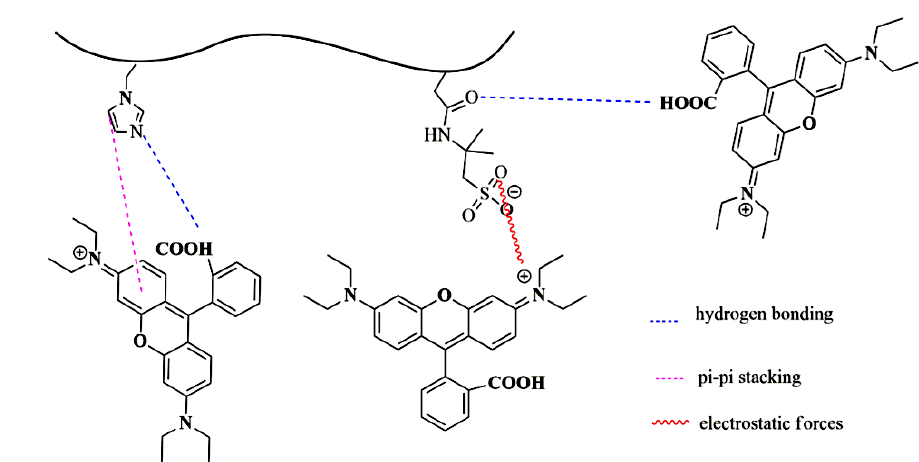
Scheme 3 Schematic interactions of Rh B onto the p(AMPS-Na + - co -VIm) hydrogel Scheme 3. Schematic interactions of Rh B onto the p(AMPS-Na + - co -VIm)